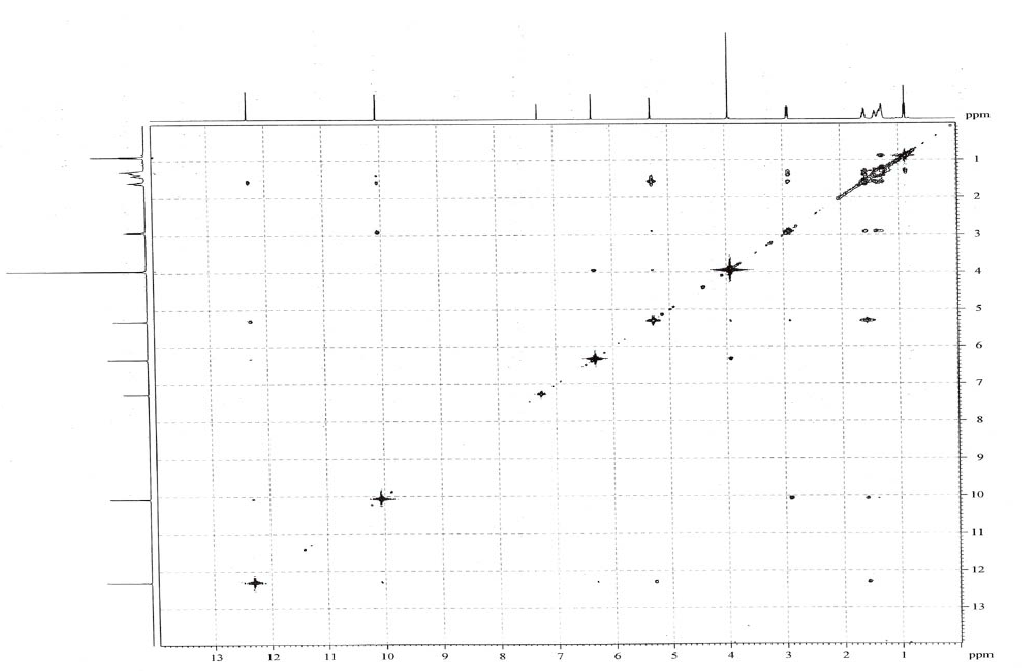
Figure 3 . The NOE spectra of ( 1